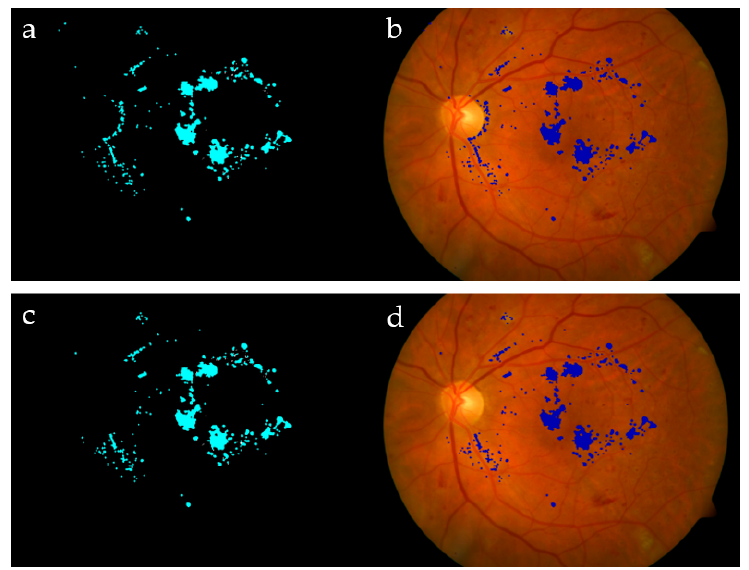
Figure 12. Dilating extracted exudates around the OD: without dilation ( a , b ) and with dilation, using SE = 45 ( c , d ).